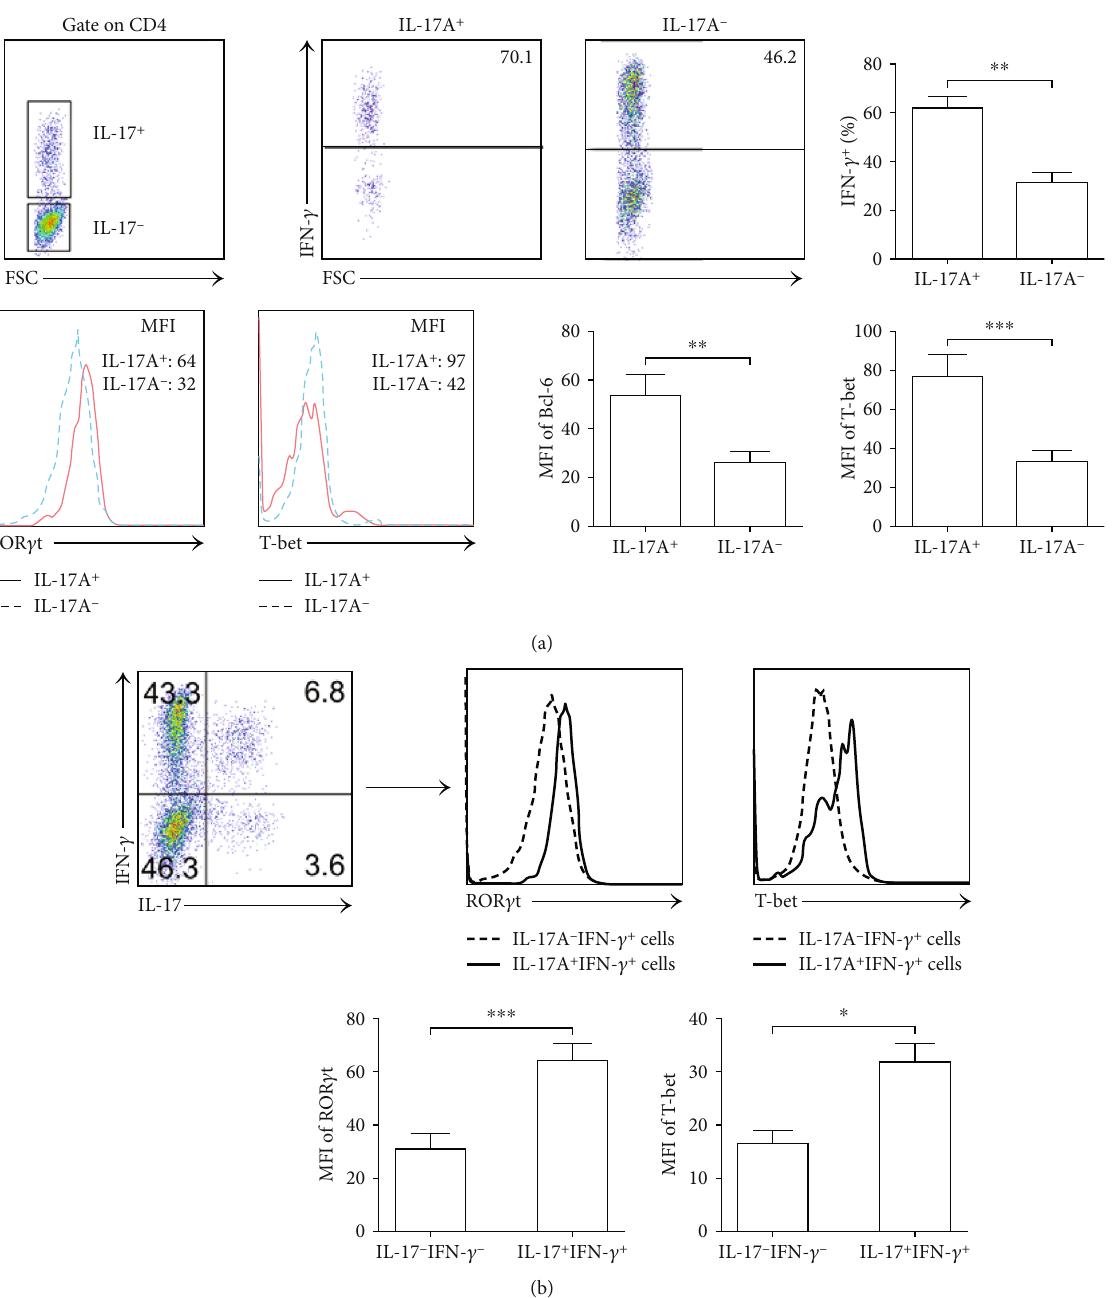
Figure 5: Transcription factor expression in CD4 + L-17 + IFN- γ + T cells from NP tissues. (a) IL-17A + and IL-17A - cells were gated on CD4 + T cells in NP tissues. The expression of IFN- γ , ROR γ t, and T-bet was analyzed ( n = 12 ). (b) CD4 + T cells from NP tissues were gated on the expression of IL-17A and IFN- γ . Representative FACS and summary data showed the expression of ROR γ t, T-bet in IL-17 + IFN- γ + , and IL-17 - IFN- γ - cells ( n = 12 ). Data were shown as the mean ± SEM . Statistical signi fi cance was determined with the Mann – Whitney test. ∗ p < 0 : 05 ; ∗∗ p < 0 : 01 ; ∗∗∗ p < 0 : 001